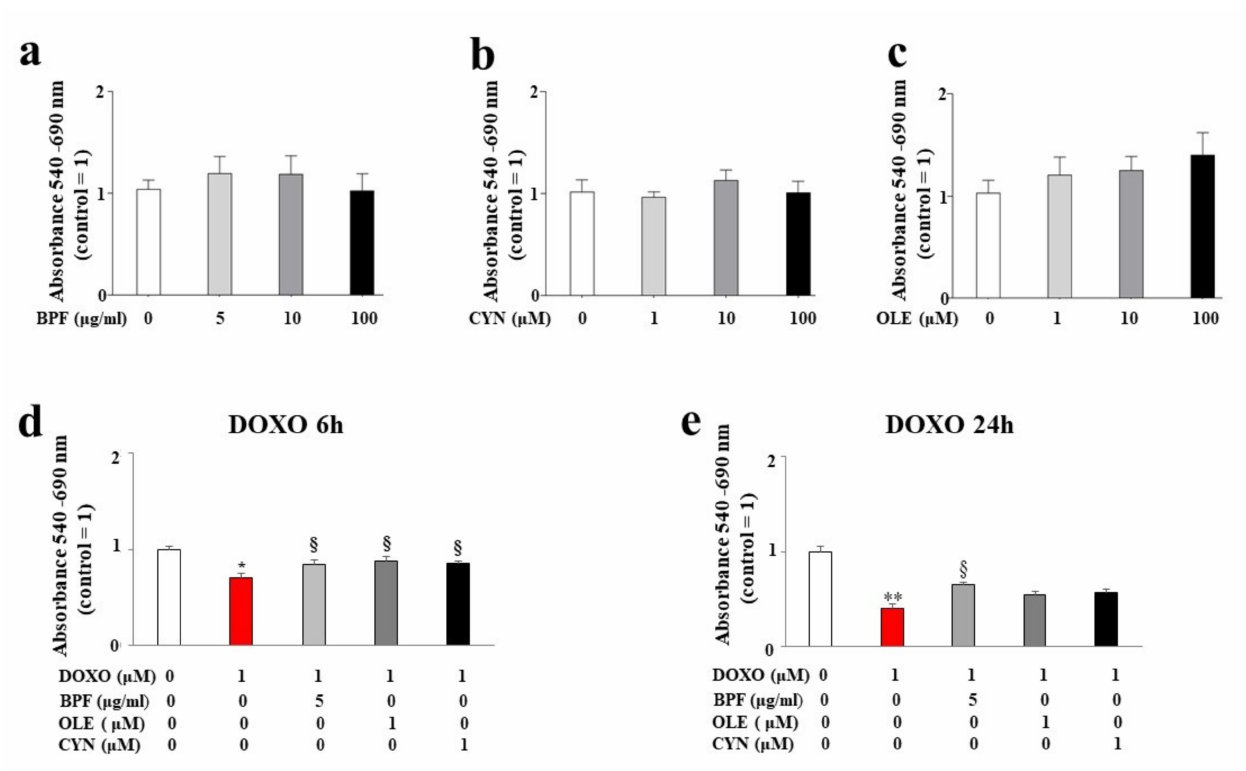
Figure 1. Measurement of cell viability. Cell viability following treatment with different concentrations of BPF (panel a ), OLE (panel b ), and CYN (panel c ) was determined. The doses of the natural compounds were chosen arbitrarily and did not result in a reduction in cell viability compared with control cells. Cell viability after 24 h of pre-treatment with the lowest concentrations of BPF (5 µ g/mL), OLE (1 µ M), or CYN (1 µ M), and subsequent treatment with 1 µ M of DOXO for 6 ( d ) or 24 h ( e ) was assessed. The values of three independent experiments are expressed as the means ± standard deviations. * denotes p < 0.05 vs. control; ** denotes p < 0.01 vs. control; § denotes p < 0.05 vs. DOXO. Analysis of Variance (ANOVA) was followed by the Tukey–Kramer comparison